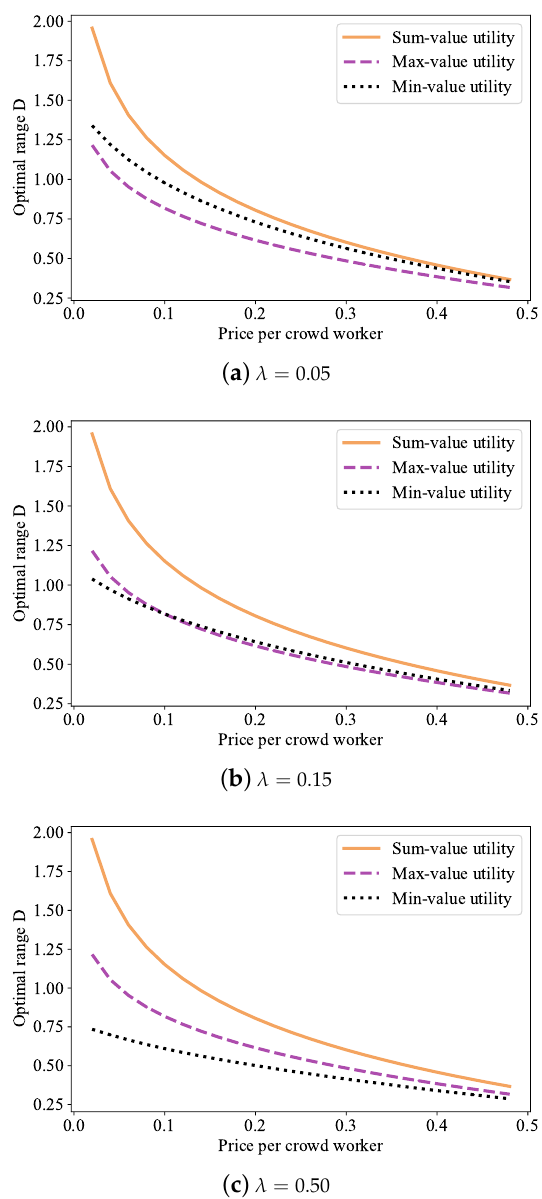
Figure 7. The optimal recruiting range with different